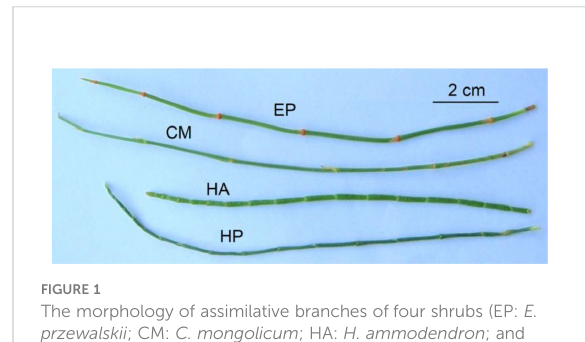
FIGURE 1 The morphology of assimilative branches of four shrubs (EP: